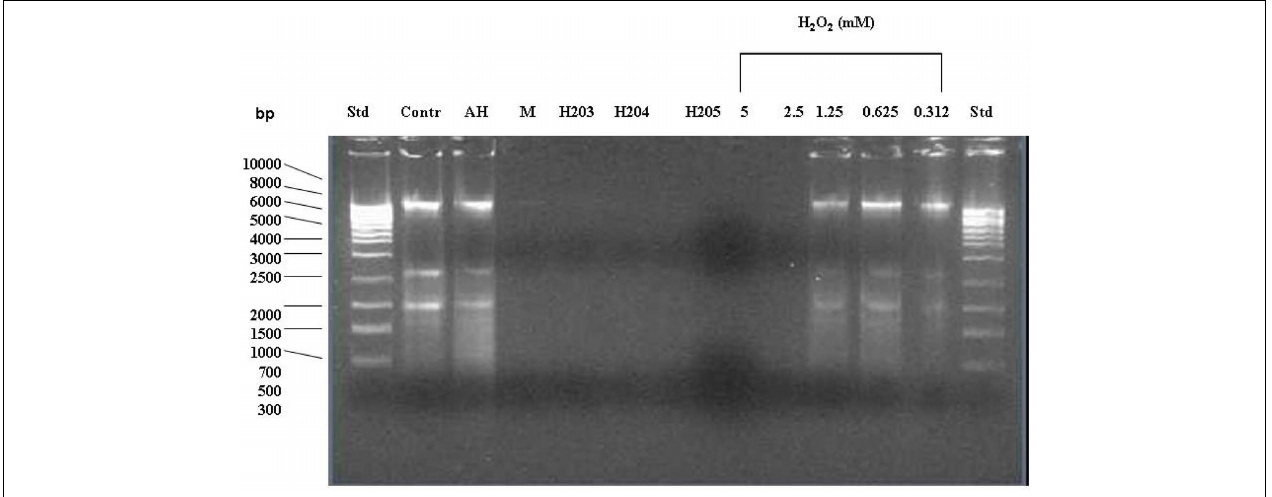
with increasing concentrations of exogenous H 2 O 2 (5–0.312mM). Untreated cells and cells treated with the sugar solution (artificial honey, AH) served as the controls.The integrity of DNA was analyzed on agarose gels.